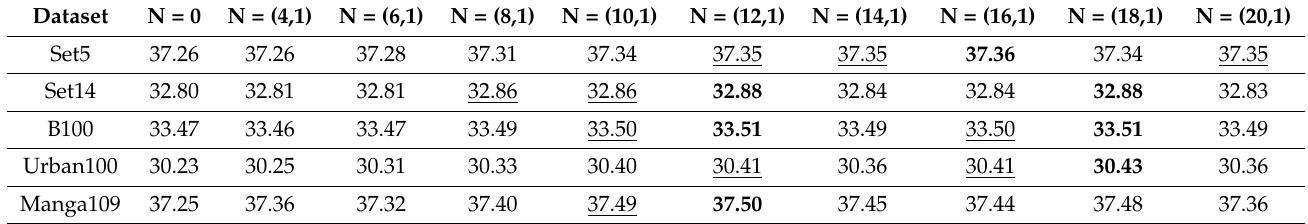
Table 2. The comparison of PSNR and SSIM of different N settings with upsampling factor 2 on benchmark datasets. Blod indicates the best performance, while Underline indicates the second